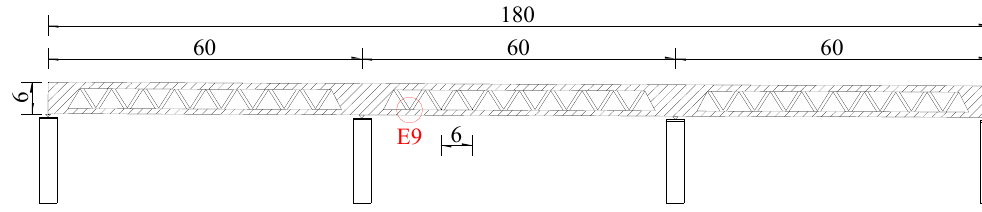
Figure 1. The most unfavorable joint (unit: m). E9: the ninth joint of the lower chord from left to right.